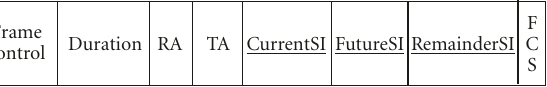
Figure 7: New RTS/CTS frame